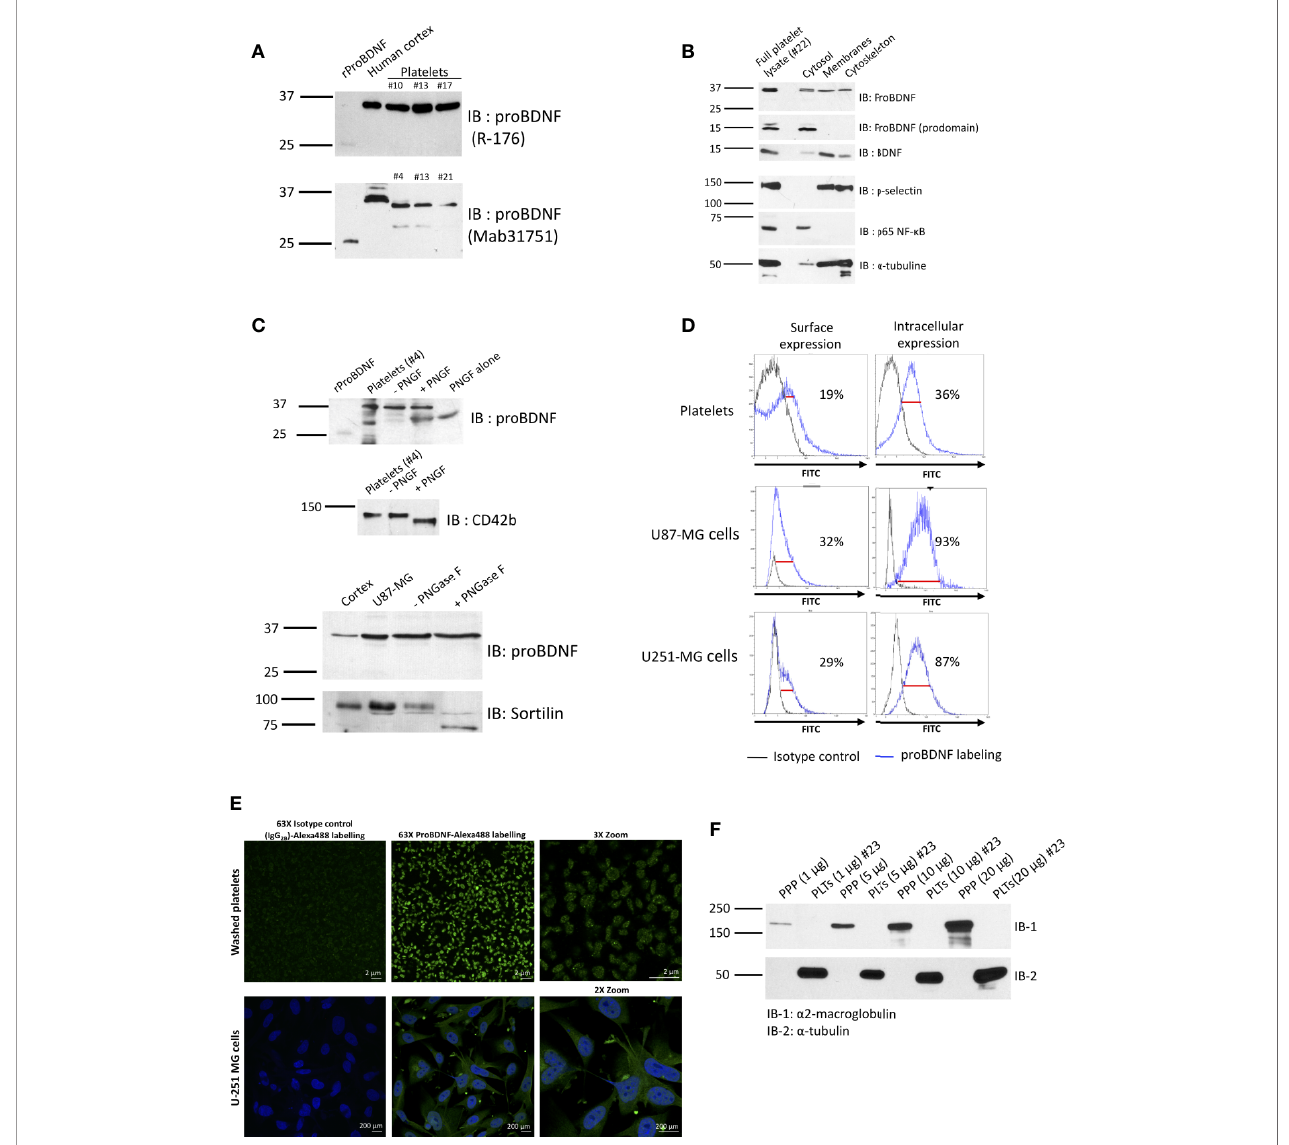
FIGURE 1 | Human platelets contain proBDNF. (A) ProBDNF immunoblotting of human washed platelet lysates (15 µg) from six different healthy volunteers. Recombinant proBDNF (3 ng) and human cortex lysate (3 µg) were used as positive controls. Molecular weight is indicated on the left (kDa) and primary antibody on the right. Experiments representative of n=9 for R-176 and n=10 for mab31751 antibody. IB, immunoblotting. (B) Immunoblotting of proBDNF and BDNF in different fractions of washed human platelets. P-Selectin was used as control protein in the membrane fraction, p65 NF- ĸ B was used as control protein in the cytosol, and a - tubulin was used as control protein in the cytoskeleton. The equivalent of the protein content of 3 x 10 7 platelets was loaded for each fraction on the gel. Representative experiment of n=4 different volunteers. (C) ProBDNF treatment with PNGase F in washed human platelet lysates. U87-MG glioblastoma cells were used as a control. rProBDNF, recombinant proBDNF (3 ng); cortex, human cortex lysate (3 µg); platelets, whole human platelet lysate (representative experiment of n=4 different volunteers, 7.5 x 10 8 platelets per well); − PNGF, platelets treated with GlycoBuffer, and incubated at 37°C for 60 min without PNGase F; +PNGF, platelets treated with GlycoBuffer and incubated at 37°C for 60 min with PNGase F; PNGF alone, PNGase F incubated at 37°C for 60 min without platelet lysate. CD42b and sortilin were used as controls of protein deglycosylation in platelets and in U87-MG cells, respectively. n=3 different volunteers for PNGase treatments in human platelets and n=4 independent experiments for U87-MG cells. (D) Representative fl ow cytometry experiment showing surface and intracellular proBDNF in human washed platelets and in U87-MG and U251-MG glioblastoma cell lines. Mouse IgG 2b was used as isotype control. Percentage of expression are indicated on the fi gure. n=10 different healthy volunteers for human platelets; n=3 independent experiments for each glioblastoma cell line. (E) Confocal microscopy imaging of proBDNF in human permeabilized washed platelets (top) and in permeabilized U-251 MG cells (bottom). Mouse IgG 2b was used as isotype control. ProBDNF was labelled using Alexa488 fl uorochrome (in green). Nuclei were stained with DAPI (in blue). Scale bar = 2 µm and 200 µm for washed platelets and U-251 MG cells images, respectively. (F) Immunoblotting of a 2 -macroglobulin at increasing quantities of loaded proteins (1 – 20 µg) obtained from a washed platelet lysate or platelet- poor plasma (PPP) from the same individual (#23). a -tubulin was used as loading control. Molecular weight is indicated on the left (kDa) and primary antibody on the right. PPP, platelet poor plasma; PLTs, platelets; IB,